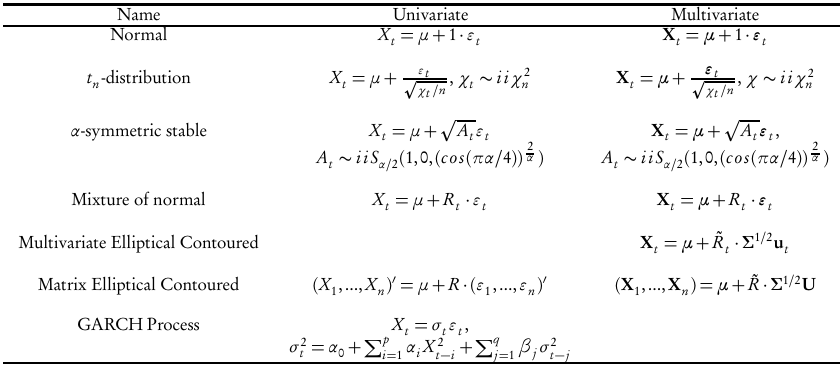
is a random variable normally t has a k-dimensional normal distribution, u is t t ) ,..., v 1 n ( γ , µ , σ 2 ) denotes an α